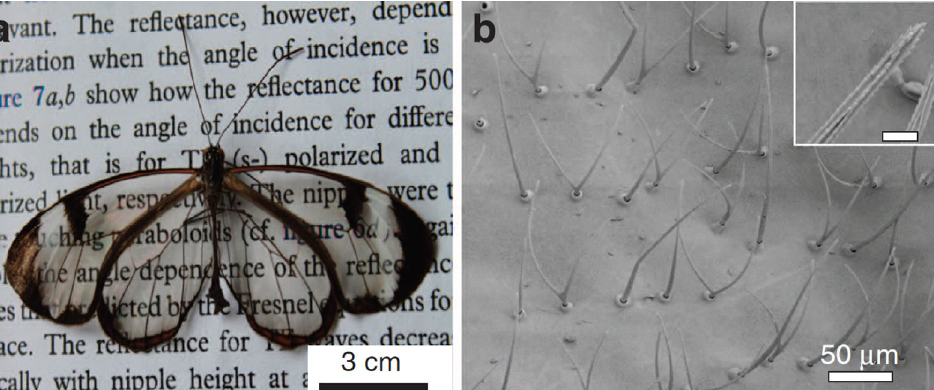
Figure 1. ( a ) Images of glasswing butterflies (Greta oto). ( b ) The image of the transparent area indicates that this area of the wing is covered in bristles or micro-hairs that are in nano scale 4 .